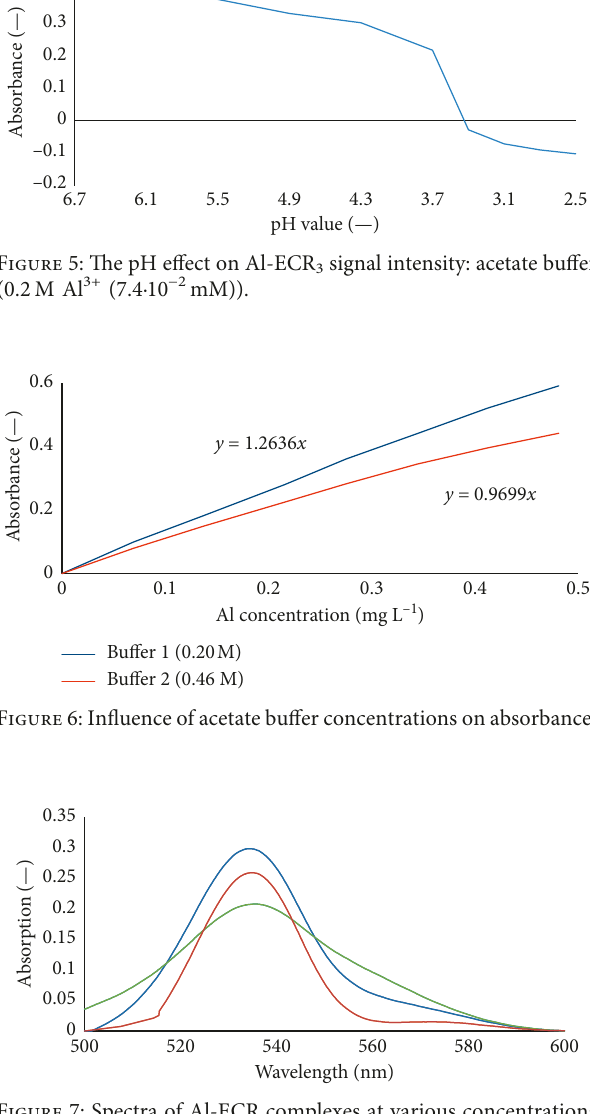
Figure 7: Spectra of Al-ECR complexes at various concentrations of acetate buffer and pH, in relation to blank probe: blue, 5.2; orange, 5.5; green, 4.9; Al 3+ (7.4 ·